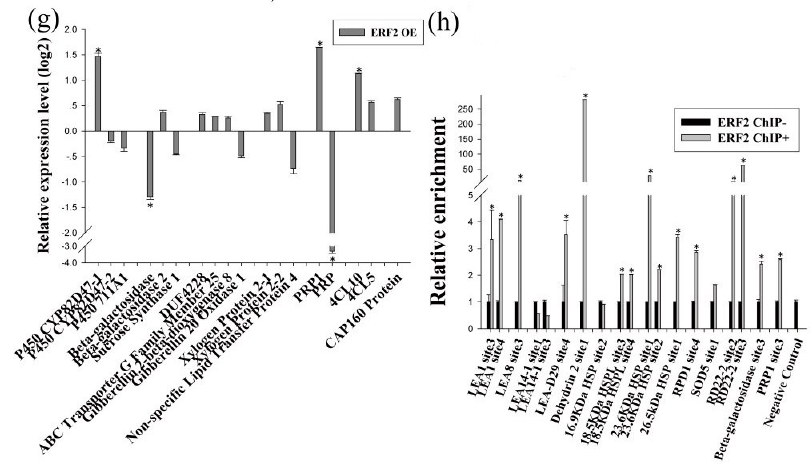
Figure 4. Determination of the genes regulated by BpERF2. ( a – g ) Investigation of the genes regulated by BpERF2 using qRT-PCR. Transcription factors ( a ), late embryogenesis abundant proteins ( b ), heat shock proteins ( c ), ROS-scavenging-related proteins ( d ), water deprivation-related proteins ( e ), stress-related proteins ( f ), and others ( g ). The transcripts of the genes in control plants (transiently transformed with empty p1307-Flag) were used to normalize their expression in the plants that transiently overexpressed BpERF2 according to qRT-PCR. ( h ) Investigation of whether BpERF2 directly regulates its target genes using ChIP. BpERF2 was fused with a Flagtag, transiently transformed into the plants, and used for ChIP. ChIP + : sonicated chromatin immunoprecipitated with anti-Flag antibody; ChIP − : sonicated chromatin immunoprecipitated without any antibody. Asterisks indicates a significant di ff erence between treatment and control plants ( p < 0.05 and | log2FC | ≥ 1).